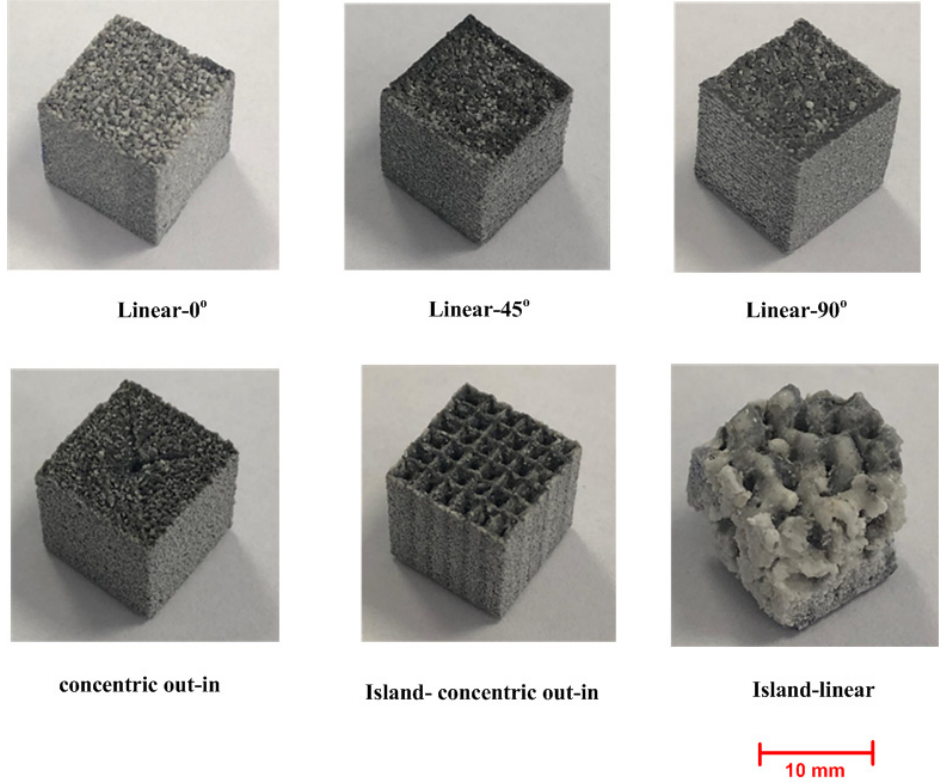
Figure 13 . Alumina samples (10 × 10 × 10 mm 3 ) printed by different scanning strategies using 95 W laser power, 200 mm/s scanning speed, and 50 µm hatching distance.